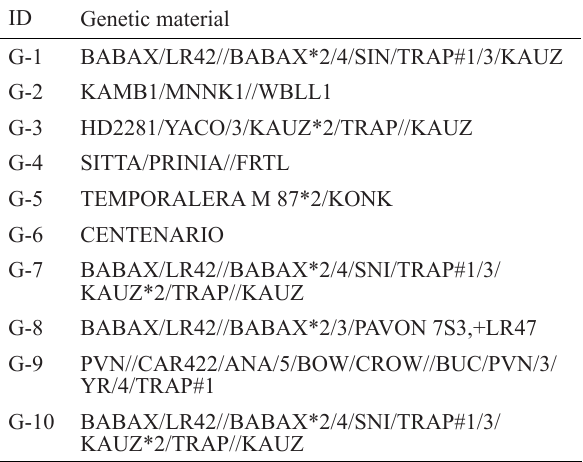
Table 1. Wheat genotypes ( Triticum aestivum L.) studied in the experiment established in La Molina, Lima,